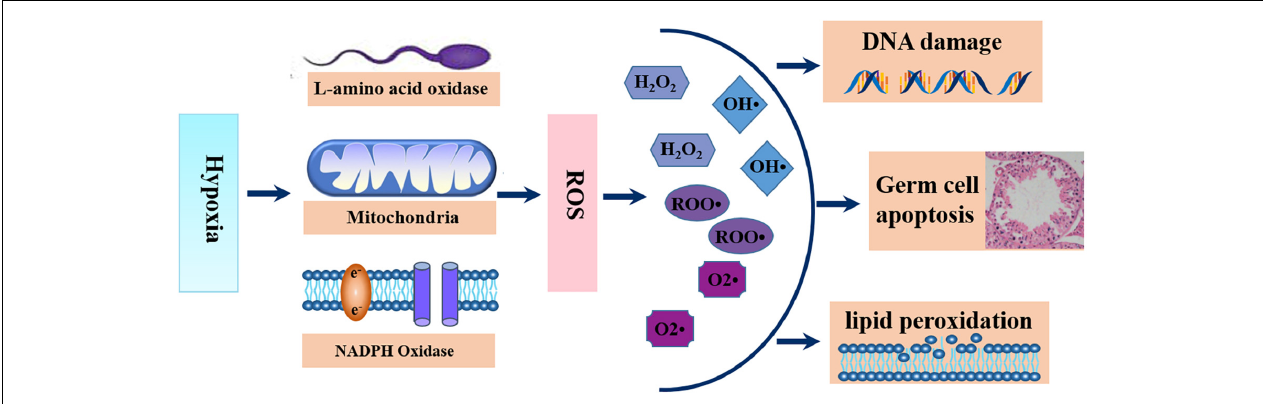
FIGURE 2 | Schematic diagram of the generations and functions of ROS. Hypoxic exposure stimulates the generation of excess ROS from sperm mitochondria, cytosolic L-amino acid oxidases, and plasma membrane nicotinamide adenine dinucleotide phosphate oxidases, leading to sperm lipid peroxidation, sperm DNA damage and germ cell